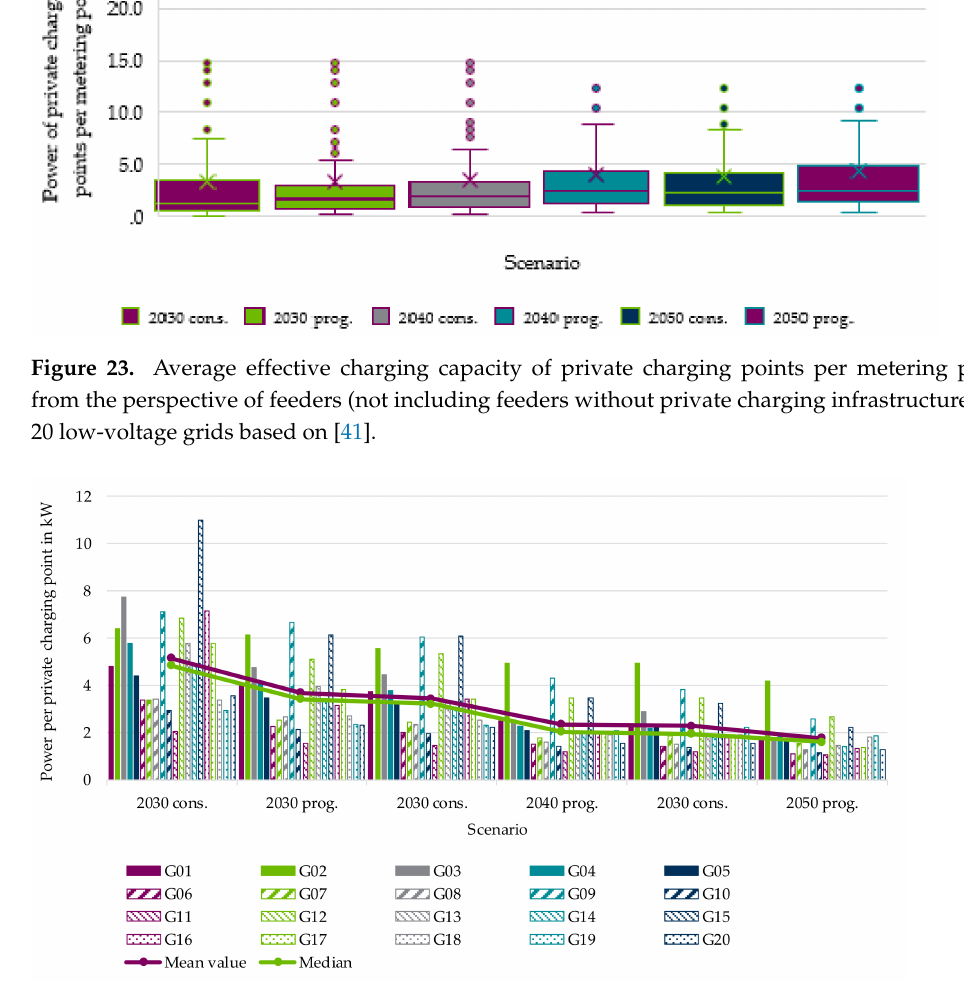
Figure 24. Average effective charging power per private charging point from the perspective of local distribution transformers for 20 low-voltage grids based on